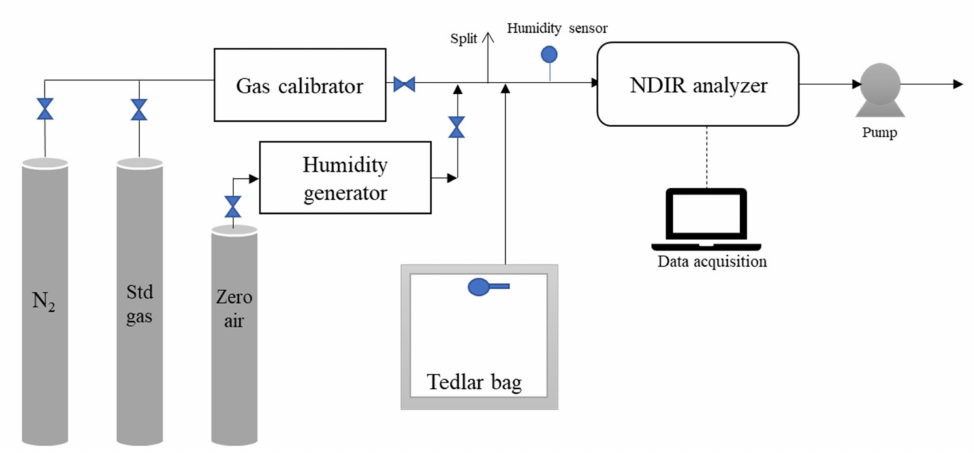
Figure 2. Experimental set-up for the investigation of the interference effect of the NH 3 BPF. NDIR: non-dispersive infrared; Std: